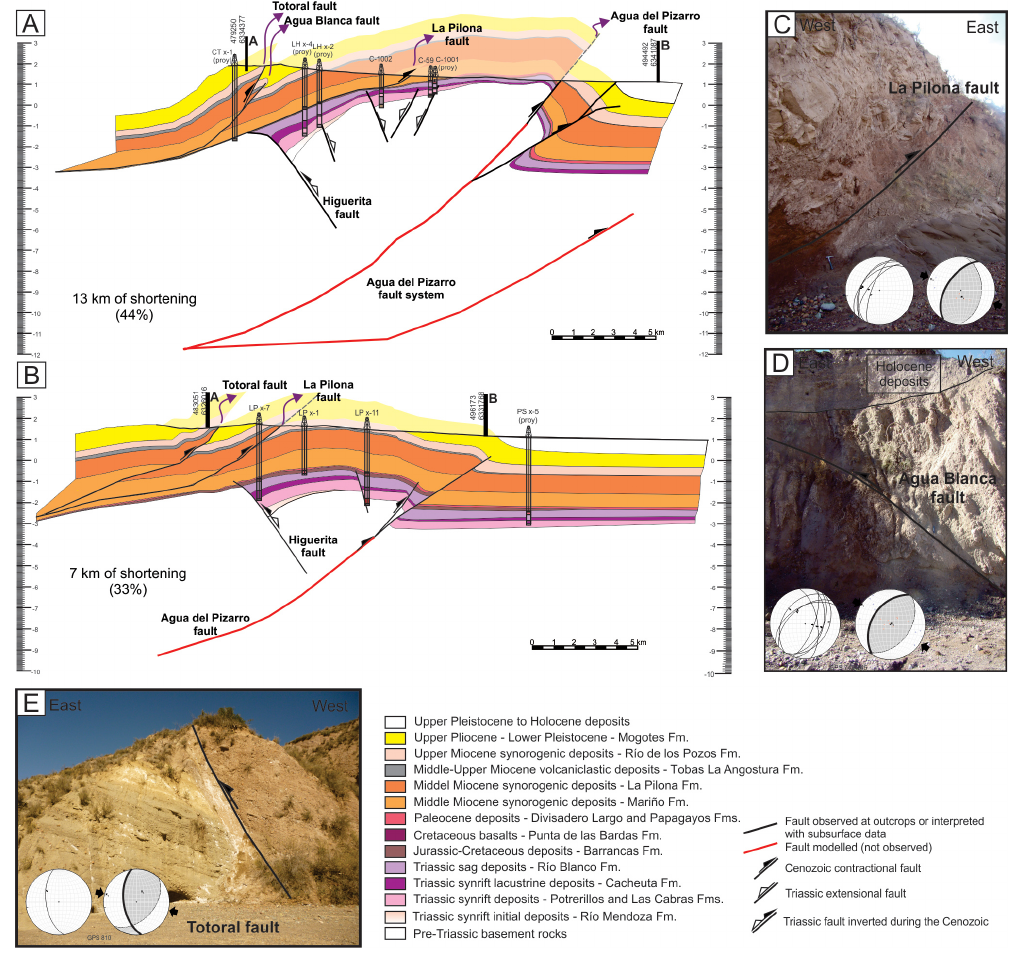
Figure 5. Cacheuta (a) and La Pilona (b) cross sections. See location at Fig. 4. (c) Photograph looking north and kinematic data of the La Pilona fault. Data were taken along the La Pilona cross section. (d) Photograph looking south and kinematic data of the Agua Blanca fault, close to the Cacheuta cross section. (e) Photograph looking south and kinematic data of the Totoral